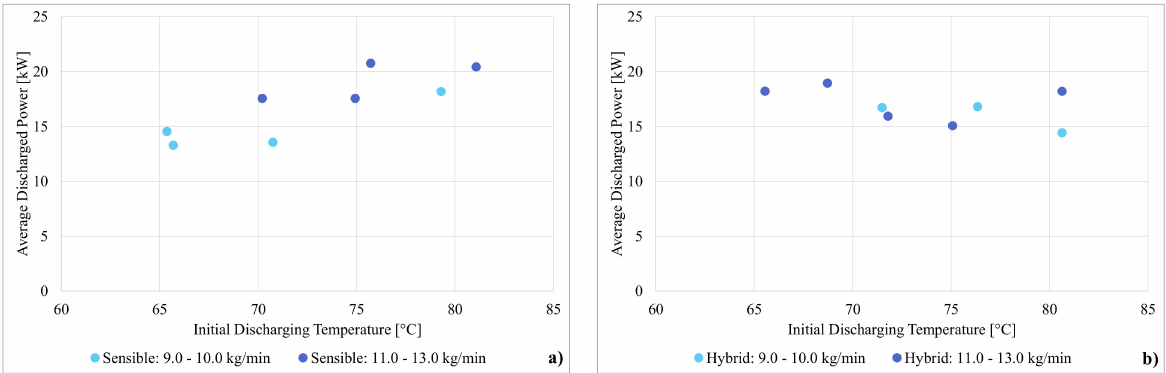
Figure 10. Average discharging power as function of initial discharging temperature and flow rate for sensible ( a ) and hybrid ( b ) TES